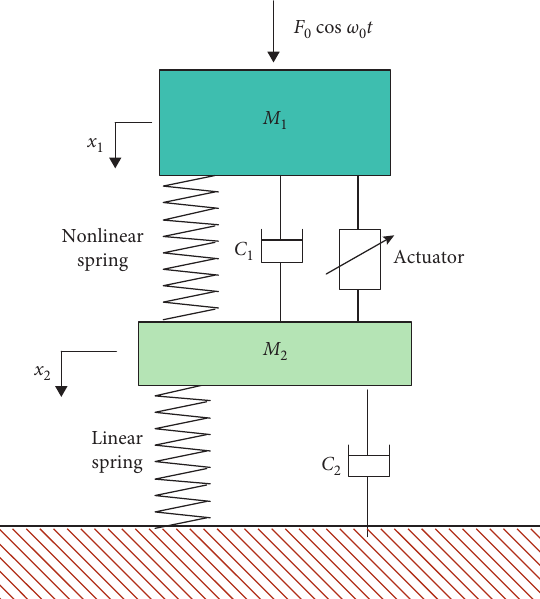
Figure 4: The structure diagram of a double DOF